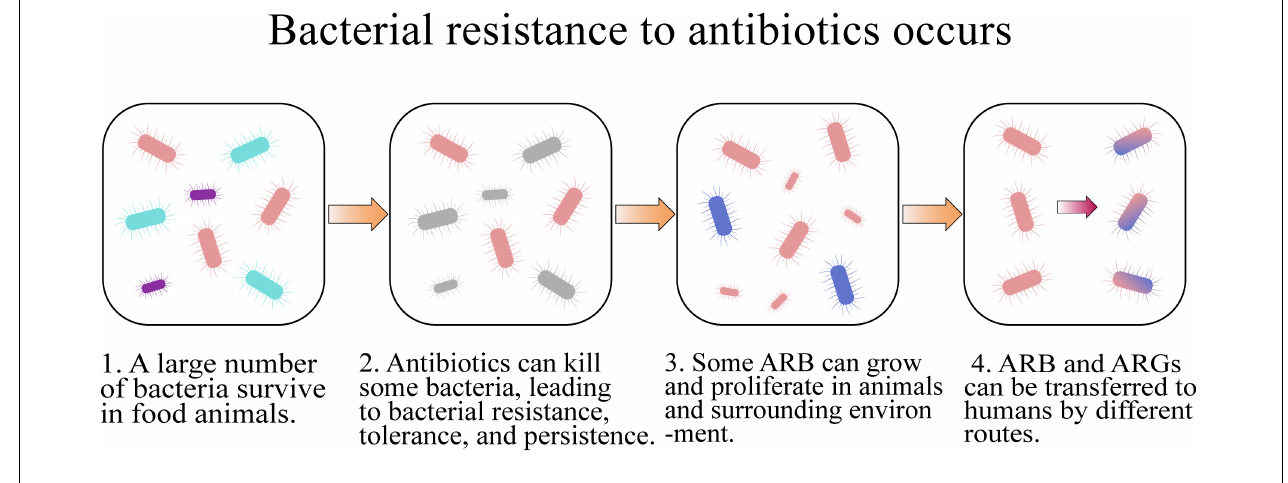
FIGURE 2 | How bacterial resistance to antibiotics occurs.